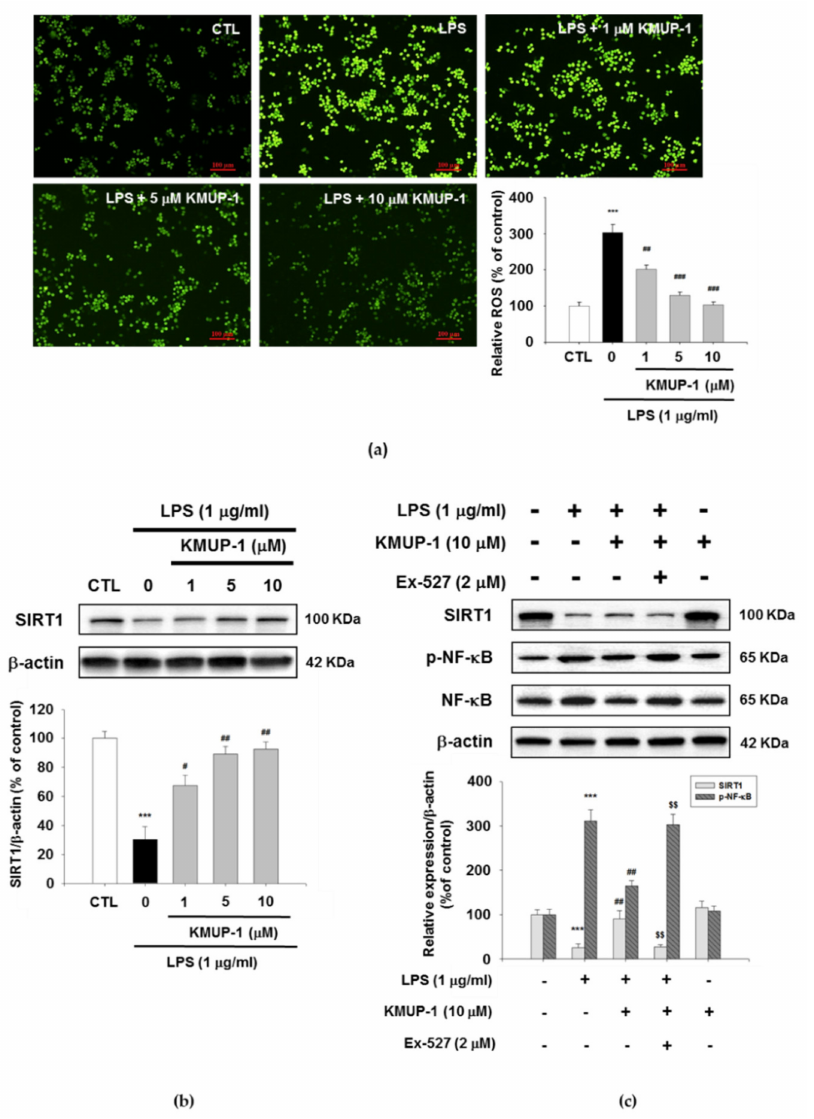
Figure 6. Effects of KMUP-1 on LPS-induced oxidative stress and NF- κ B activation regulated by SIRT1 in RAW 264.7 cells. ( a ) The cellular oxidative stress was determined by DCFH-DA staining (100 × magnification). A representative Western blots demonstrating ( b ) SIRT1 protein levels ( c ) SIRT1 and NF- κ B phosphorylation levels. Values are presented as mean ± SEM, n = 3. *** p < 0.001 compared to control group. # p < 0.05, ## p < 0.01, ### p < 0.001 compared to LPS group. $$ p < 0.01 compared to LPS + KMUP-1